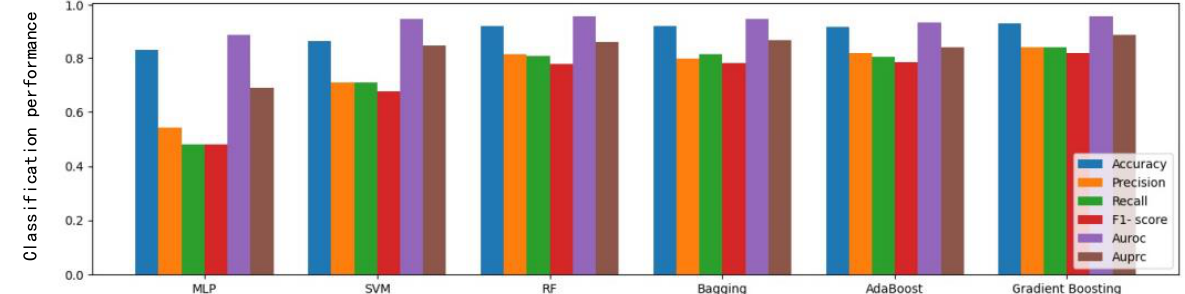
Figure 7. Other performance metrics for six classifiers using K-fold cross-validation.